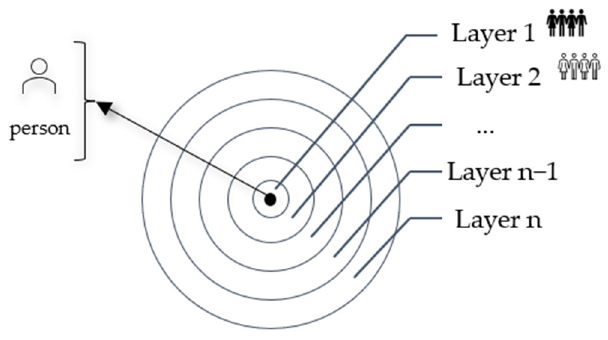
Figure 3. Multi-layer family model.